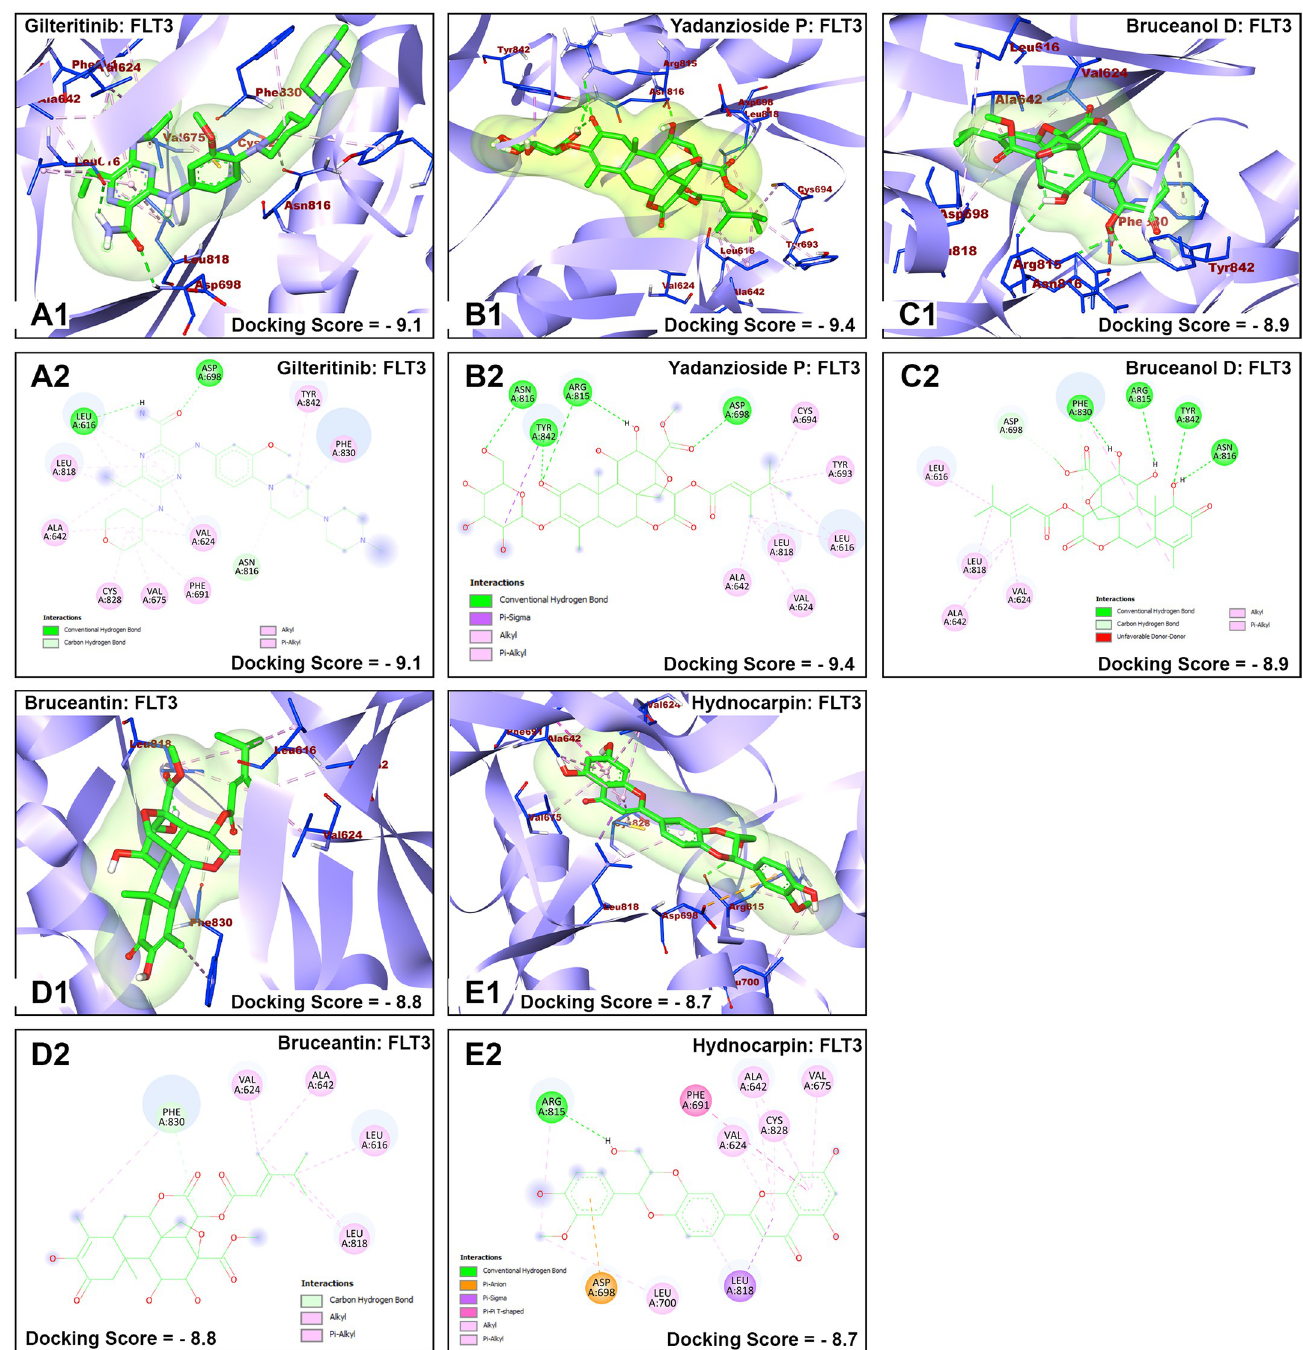
Fig 6. Molecular docking analysis of gilteritinib and selected B . antidysentrica phytochemicals against FLT3 AML receptor. (1) 3D pose views of interaction of compounds with AML receptor FLT3. (2) 2D pose views of interaction of compounds with AML receptor FLT3.